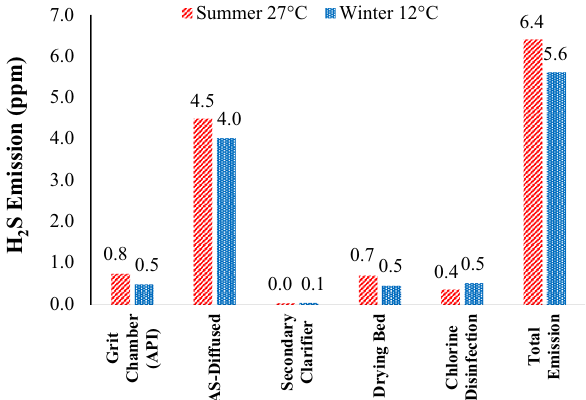
Figure 5. Emission of H 2 S to atmosphere from each unit (ppm) during summer and